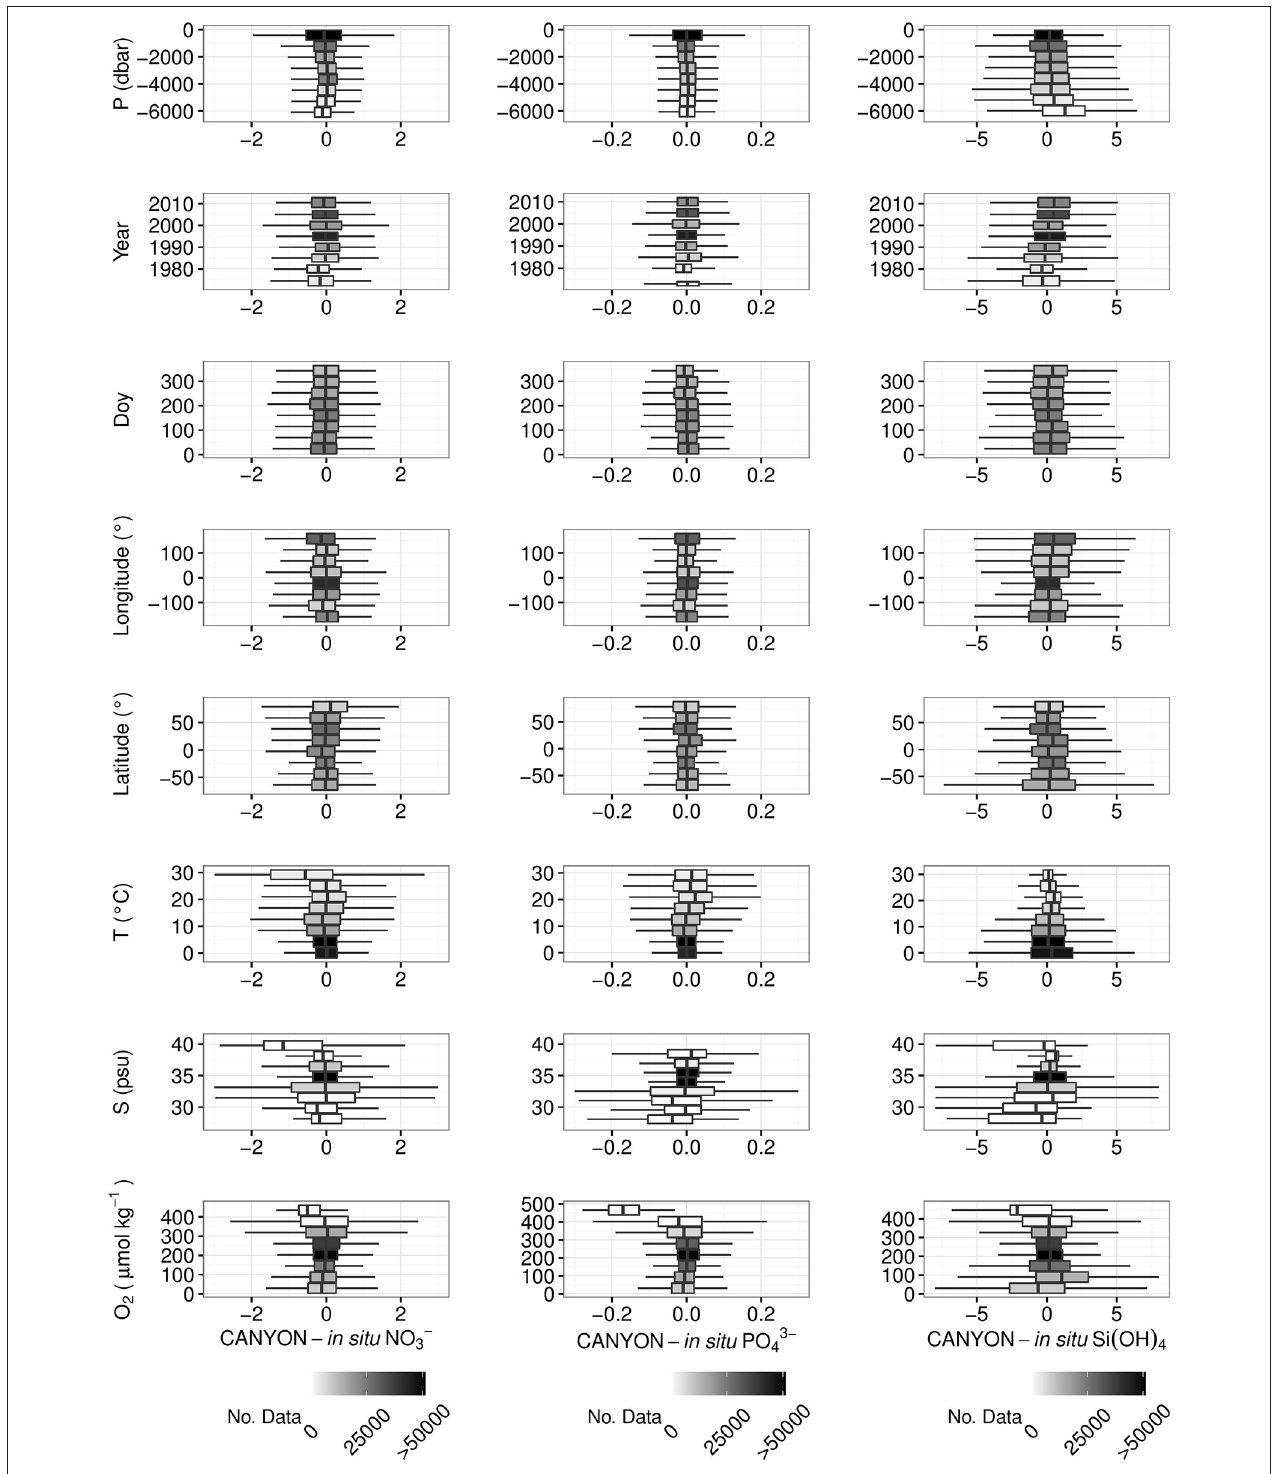
FIGURE 4 | Box plots of the differences between CANYON estimates minus GLODAPv2 reference measurements for (from left to right): NO 3 − ( µ molkg − 1 ), PO 43 − ( µ molkg − 1 ), and Si(OH) 4 ( µ molkg − 1 ) vs. the variable indicated on the left: pressure (P), year, doy, longitude, latitude, temperature (T), salinity (S), O 2 . The intensity of the shading in each box refers to the number of data. The intervals were created by dividing the range of values in eight equal intervals. For each box, the negative and positive whiskers represent the Q1–1.5*IQR and Q3 1.5*IQR, respectively, where Q1 is the 0.25 quantile, Q3 the 0.75 + quantile, and IQR the inter-quantile range. The width of each box represents the IQR and the middle line the median of the